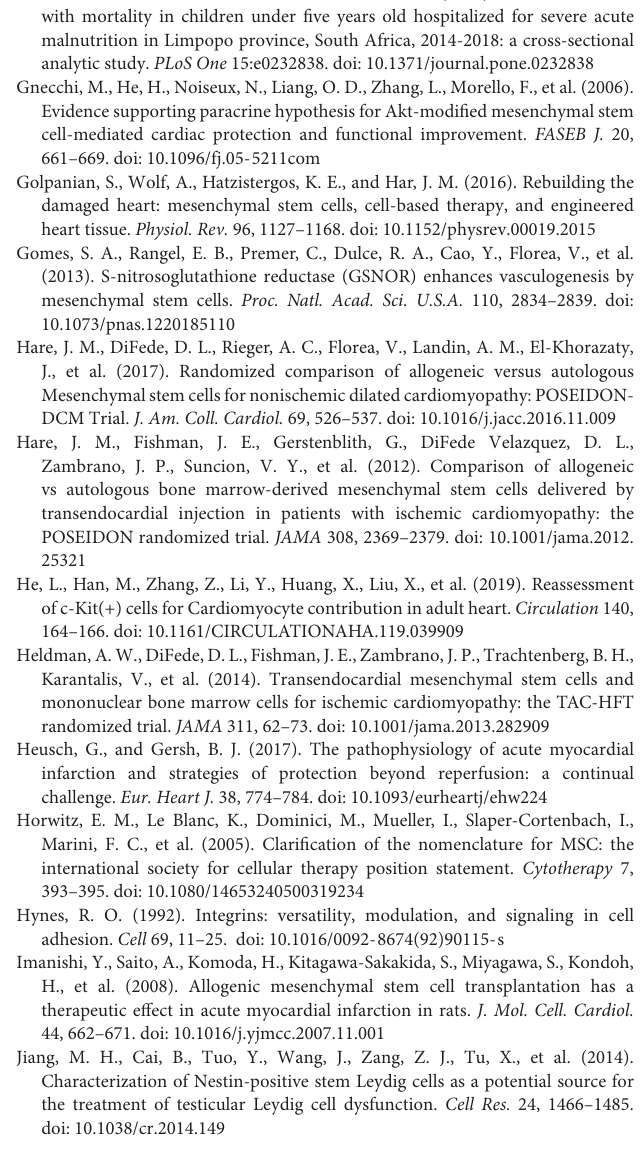
Supplementary Figure 1 | Isolation and characterization of the three subpopulations. (A) Isolation of CD51 + PDGFR α − MSCs, CD51 + PDGFR α + MSCs, and CD51 − PDGFR α + MSCs using FACS; the positive rates of CD51 + PDGFR α + , CD51 + PDGFR α − , and CD51 − PDGFR α + were about 2.09, 3.89, and 3.6%, respectively. Fifty neonatal C57BL/6 mice were used. (B) Morphology of the three subpopulations when cultured for 5 days in vitro